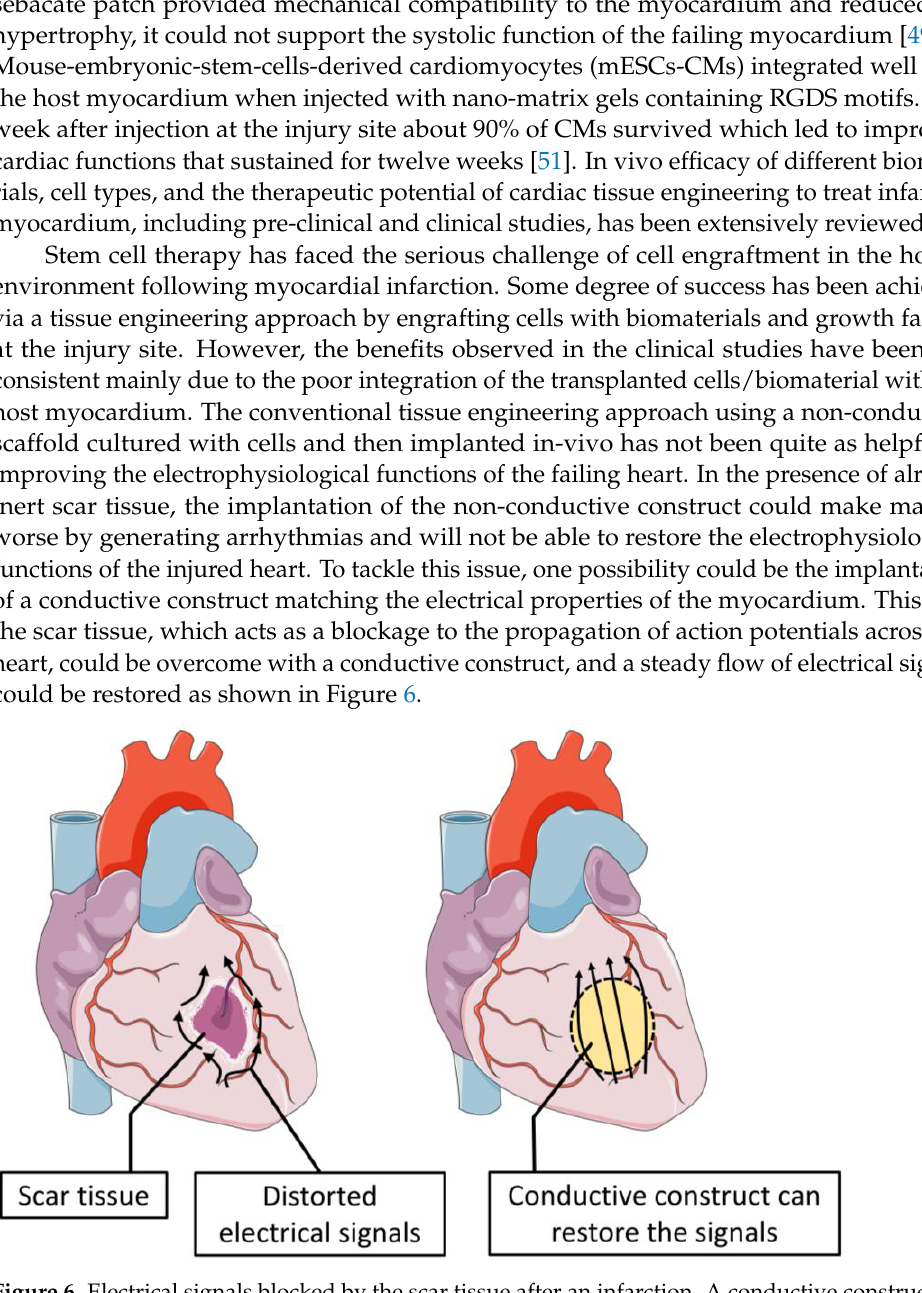
Figure 6. Electrical signals blocked by the scar tissue after an infarction. A conductive construct can restore the signal transmission through